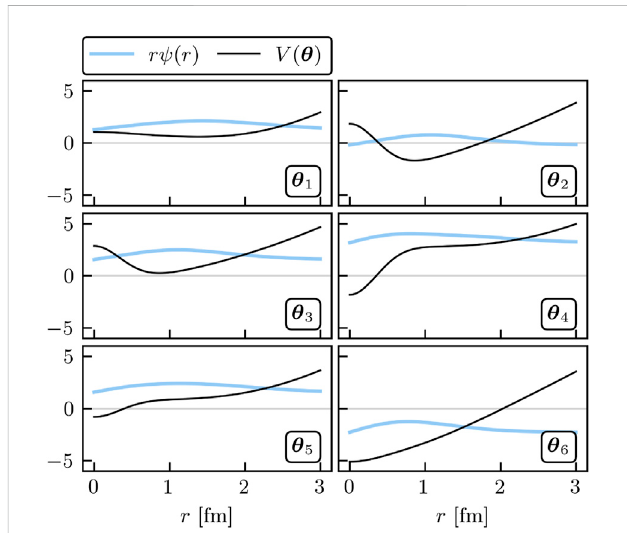
FIGURE 3 Basis functions for training the snapshot-based eigen-emulator. The black curves show the potential, and the blue curves show the wave functions as functions of the radial coordinate r . The wave functions are offset vertically by their corresponding energies for clarity. See the main text for